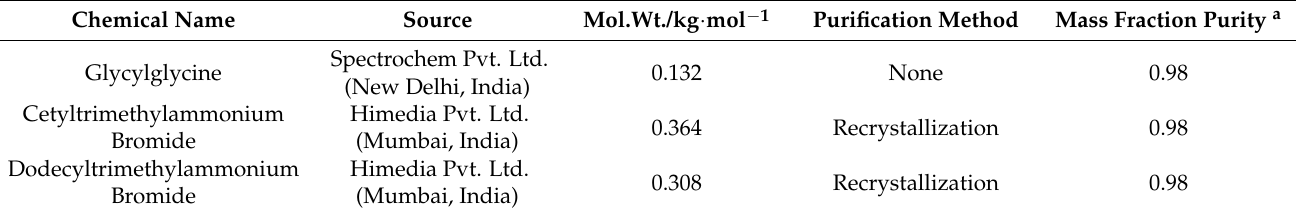
Table 1. Specification of chemicals